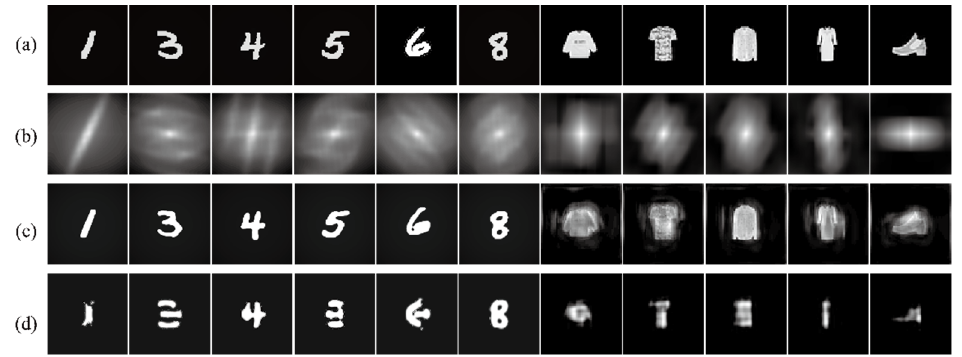
Figure 8. Comparison of the reconstructed results without or with physics priors. ( a ) Ground truth; ( b ) Enlarged partial views of the autocorrelation image of speckle; ( c ) Results using the proposed strategy; ( d ) Results without priors.